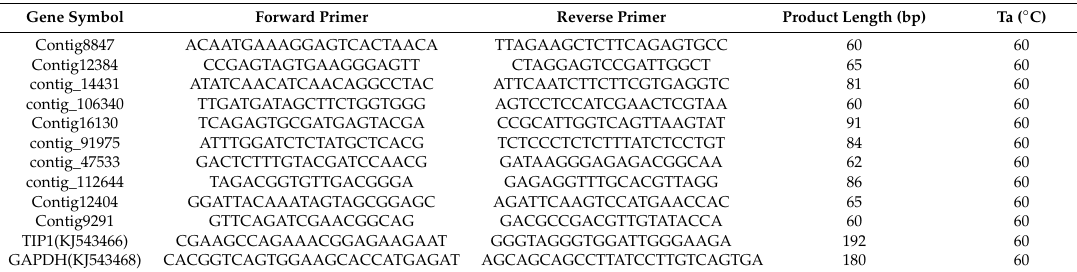
Table 8. Primers used in real-time quantitative PCR